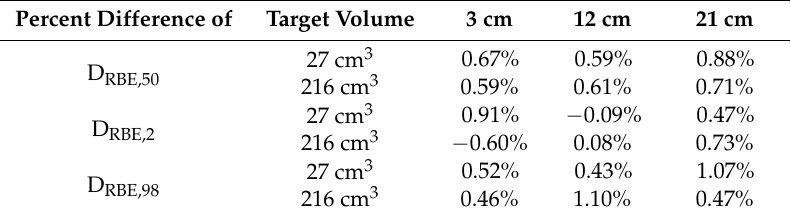
Table 1. Percent RBE-weighted dose (D RBE ) difference comparison for RBE-weighted dose-volume histogram (D RBE VH) between FRoG and Monte Carlo (MC) for proton beams.